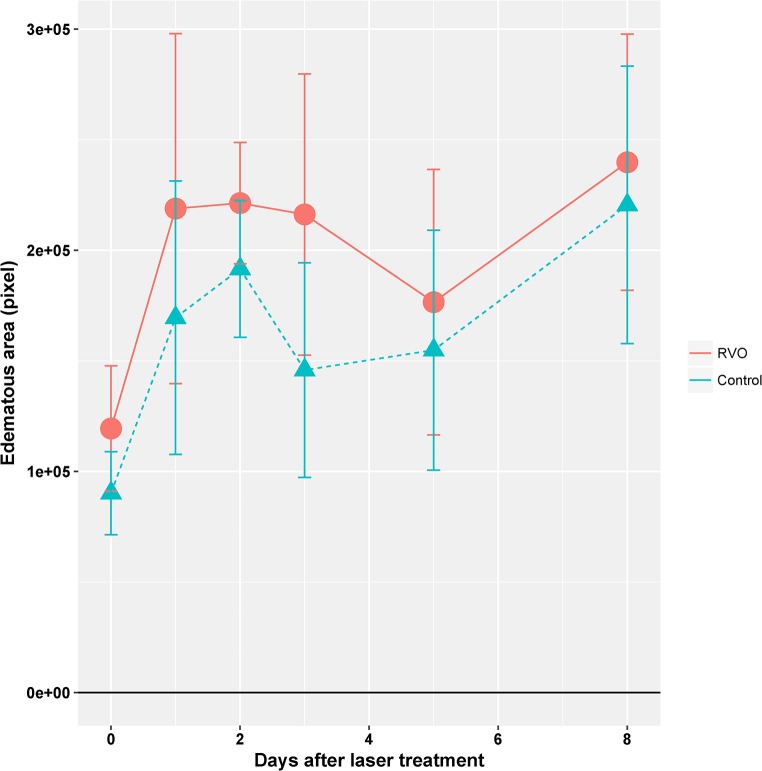
Time course of edema formation.The edematous area of the retina in fundus images like those shown in Fig x2 was evaluated. Edema is the gray area that contrasts with the brown intact retina. Though not significant, the edematous area was somewhat larger in RVO than in the control laser treatments. It increased from d0 to d1. Error bars indicate standard deviation. The values are from 11–17 retinae of the same animals used for the qPCR and RNAseq experiments. The increase at d8 is an artifact.